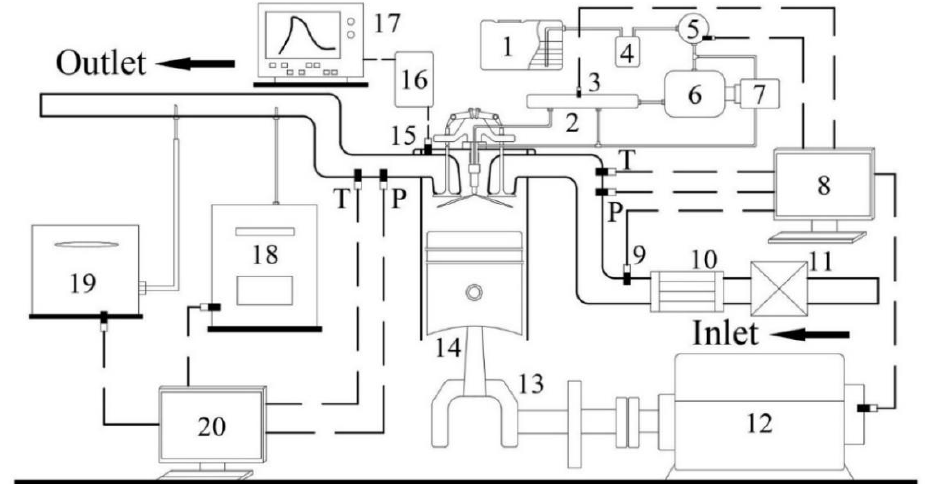
Figure 1. Schematic of experimental set-up: 1 fuel tank; 2 fuel rail; 3 pressure sensor; 4 fuel filter; 5 fuel consumption meter 6 high pressure pump; 7 electric motor; 8 PC and control unit; 9 air flow meter; 10 intercooler; 11 air filter; 12 dynamometer; 13 crankshaft; 14 piston; 15 cylinder pressure sensor; 16 charge amplifier; 17 combustion analyzer; 18 gas analyzer; 19 smoke meter; 20 PC and control unit.